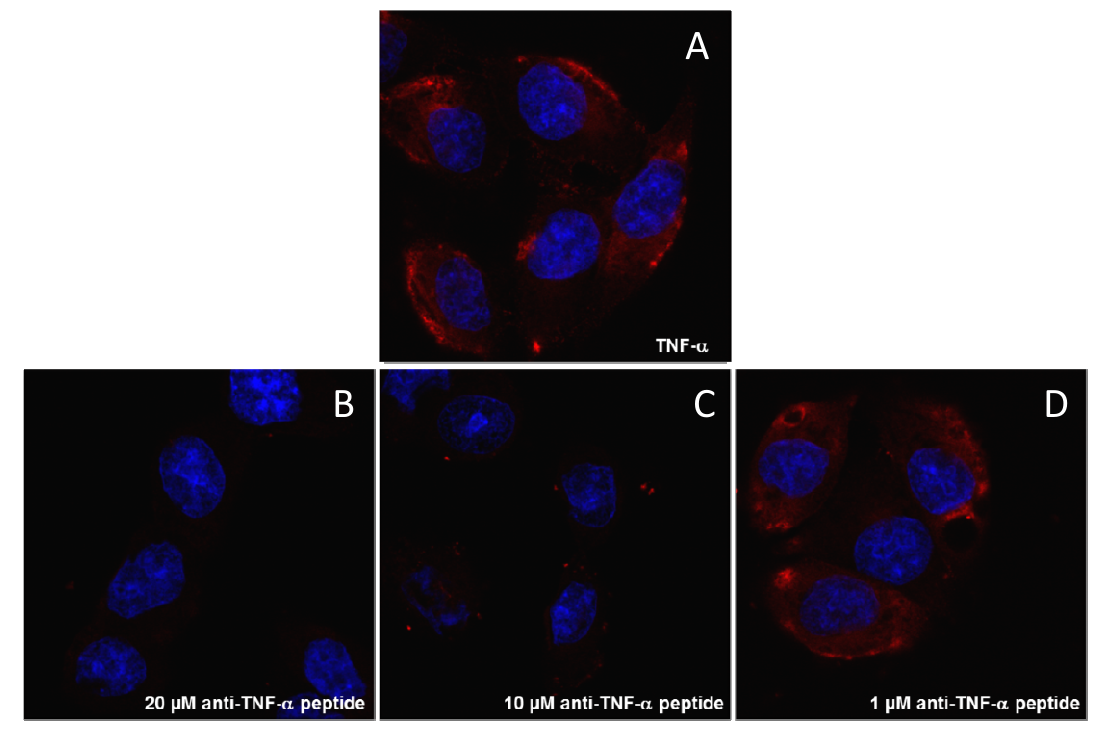
Figure 5. The branched anti-TNF- α peptide inhibits TNF- α binding to human melanoma cells. The red signal is due to hTNF- α binding (3 nM) to membrane receptors present on A375 cells (A). Incubation of hTNF- α with the branched anti-TNF- α peptide produces a dose-dependent decrease in the red signal (B-D). Nuclei were stained with DAPI